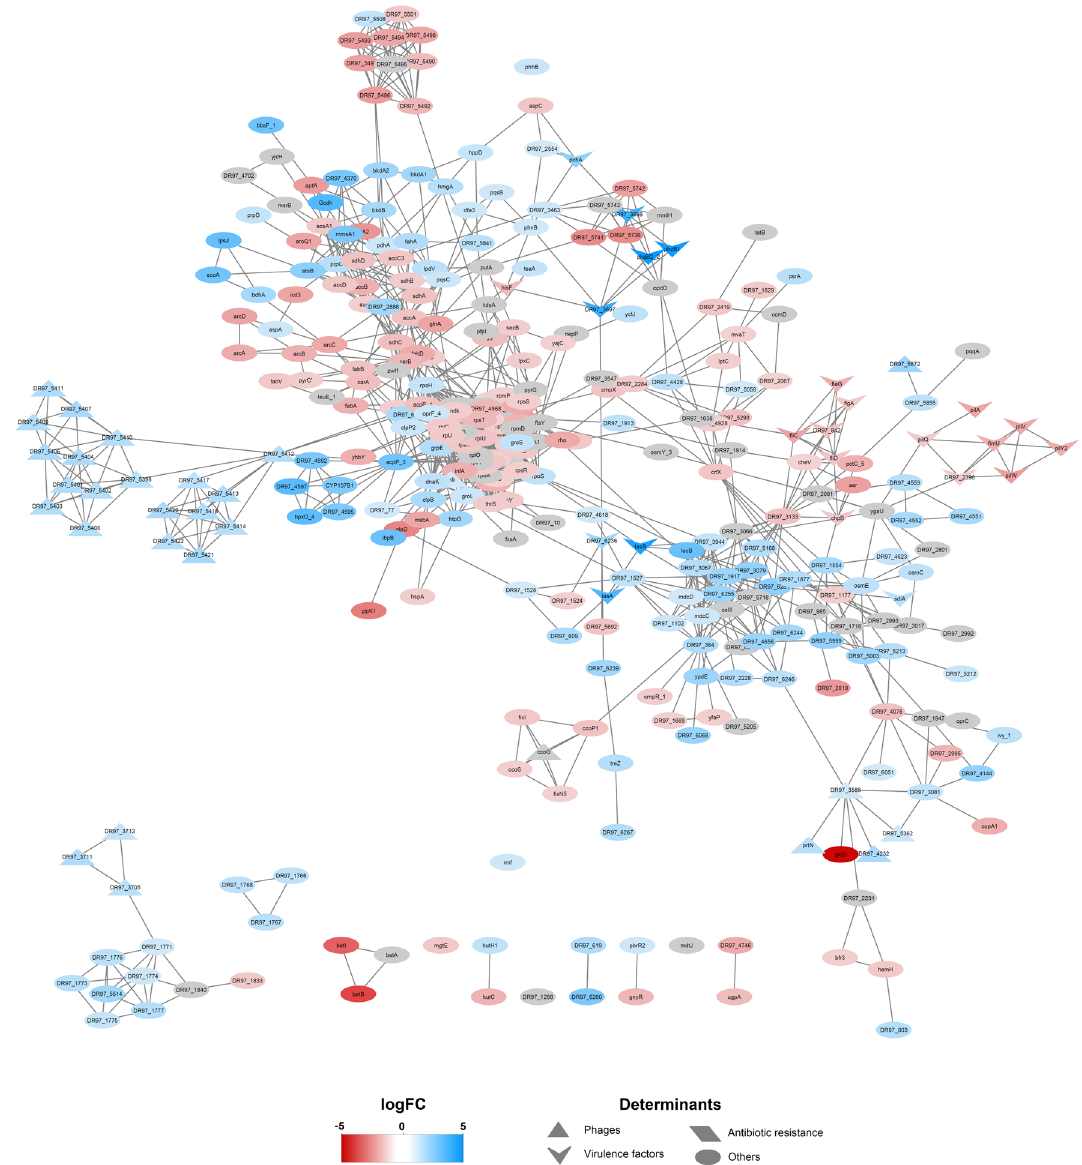
interactions between genes were predicted. To build the network all the DEGs in both times 2.5 and 5 h were included. A total of 342 genes resulted connected (66.0% of all DEGs) with 1685 edges in total (not connected nodes are not shown). The logFC is shown for 5 h. Gray nodes represent genes that were differentially expressed only at time 2.5 h (i.e. no logFC value is displayed at time 5 h). Details of the network by time is shown in supplementary Figure S3. Phages genes, virulence factors and antibiotic resistance genes are represented as triangles, arrowheads and rhomboids, respectively. Down-regulation (red tones) and up-regulation (blue